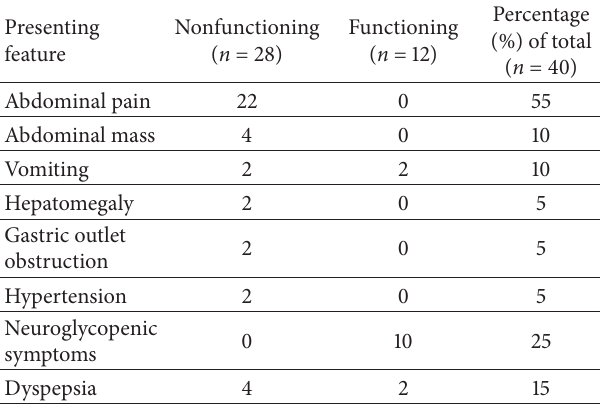
Table 4: Presenting complaints of pancreatic endocrine neoplasms.